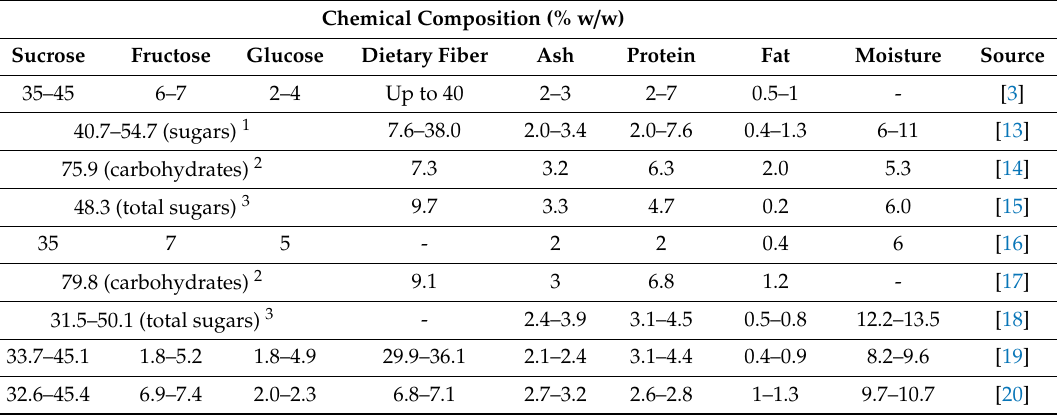
Table 1. Composition of carob ( Ceratonia siliqua L. ) flesh based on literature